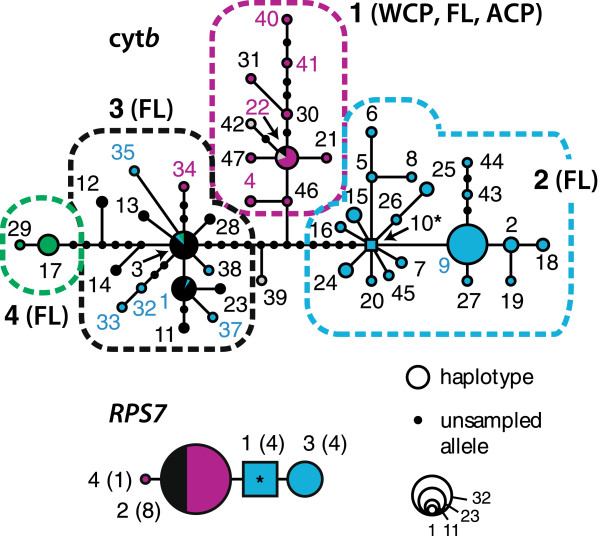
Statistical parsimony network relationships among cytb and RPS7 haplotypes (numbered). Networks were defined in TCS based on a 95% parsimony criterion. Network circles indicate haplotypes scaled according to their frequency (smallest colored circles = 1 sample; scale applies to cytb network; RPS7 haplotype frequencies are given in parentheses), lines represent 1 mutation step between haplotypes, and dotted lines enclose distinct network regions (numbered, with regions in parentheses). Colors represent haplotype identities, by SAMOVA-inferred population groups (K = 4) shown in Figure 1.